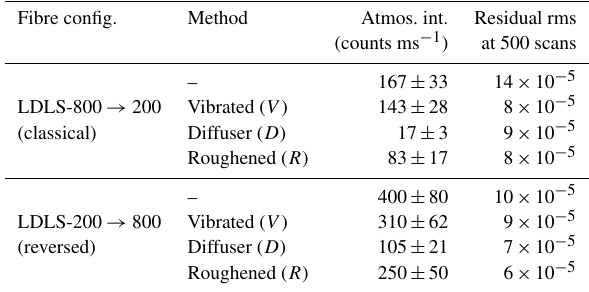
Table 4. Comparison of different mode-mixing methods with LDLS and classical (upper part) or reversed fibre configuration (lower part) and their effect on intensity and residual. The number combination in the legend indicates the fibre diameter on the light source end (first number) and spectrometer end (second number). The 800µm fibre is always coupled to a ring of six 200µm fibres. Errors in the atmospheric intensities reflect variations through alignment and at- mospheric